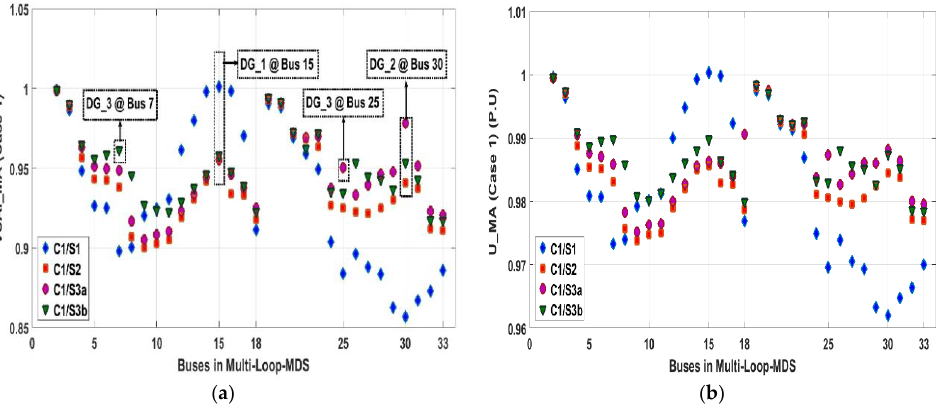
Figure 8. Case 1 for 33-bus MDS (U_Max) ( a ) VSAI trend (based on actual MDS) for VSAI_MA-LMC; and ( b ) U-profile trend for VSAI_MA- LMC based planning approach (DG operating @ pf = 0.9 ± 2.5%).